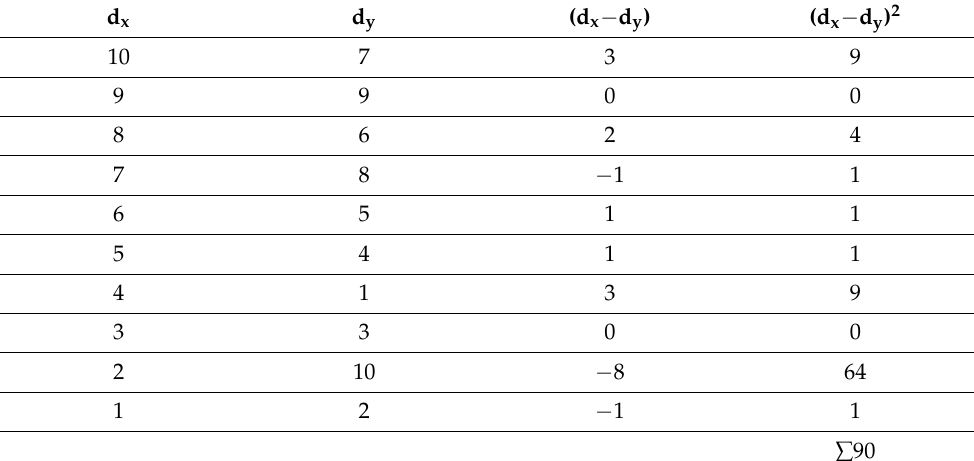
Table 9. Rank values for x and y and equations needed for the